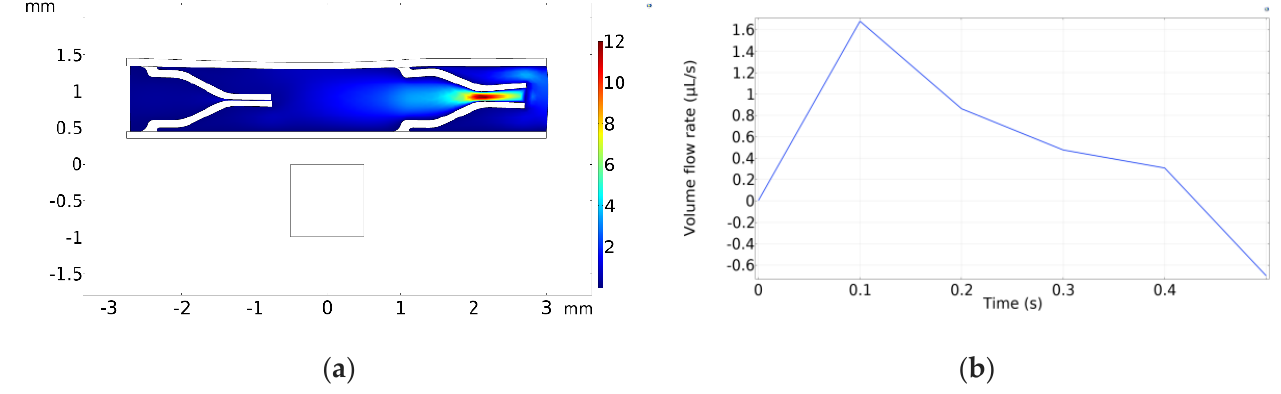
13 of 22 Figure 10. Deformation of upper wall across the pump length . Figure 11a displays the velocity field inside the pump at t = 0.1 s, when the maximum velocity occurs, whereas Figure 11b shows the total volume flow rate with respect to time. The total volume flow rate is calculated by summing the outflows from both the left and right sides. It should be noted that there is no inlet to the pump because the flow is initi- ated by the squeezing effect under the magnetic field. ( a ) ( b ) Figure 11. Simulation results for micropump without any valves. ( a ) Velocity field at t = 0.1 s. ( b ) Total volume flow rate vs. time.